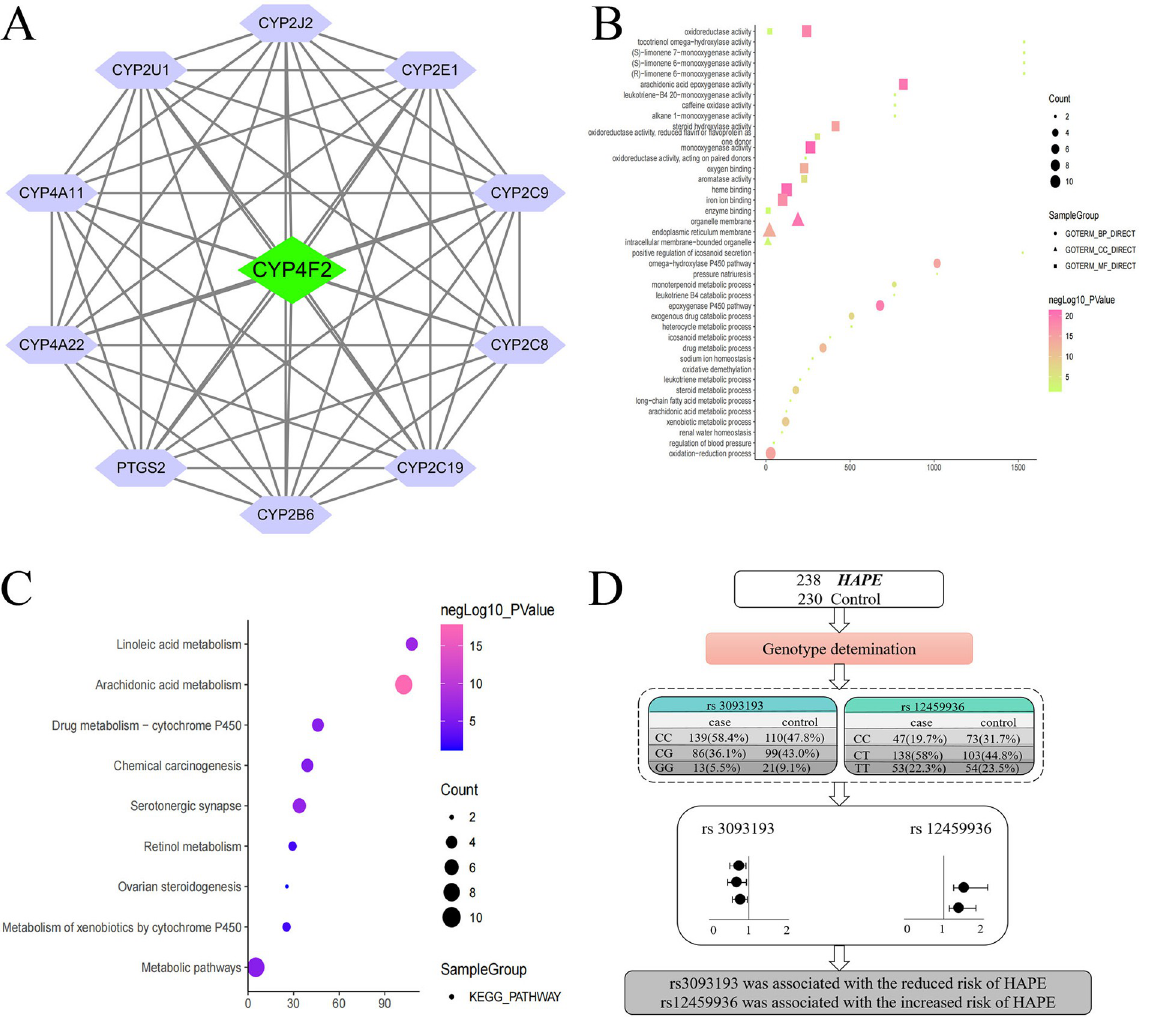
Fig 2. Functional enrichment analysis for CYP4F2 related genes. (A) The interaction of CYP4F2 with other protein (top 10). The yellow circle represents the CYP4F2 , while red circles delineate other proteins. (B) The KEGG analysis. The KEGG pathway with corresponding adjusted p- values analyzed by clusterProfiler, which are displayed in a dot plot. The color scales indicated the different thresholds of adjusted p-values, and the sizes of the dots represented the gene count of each term. (C) Gene ontology analysis. The x-axis shows significantly enriched ‘biological process (green)’ categories, ‘cellular component (orange)’ categories and ‘molecular function (purple)’ categories associated with the targets; the y-axis shows the enrichment scores ( P value) of these terms. ( D ) The flow chart. The study recruited 238 patients with HAPE and 230 healthy controls. Rs3093193 was shown to reduce the risk of HAPE, while rs12459936 was increased the susceptibility to